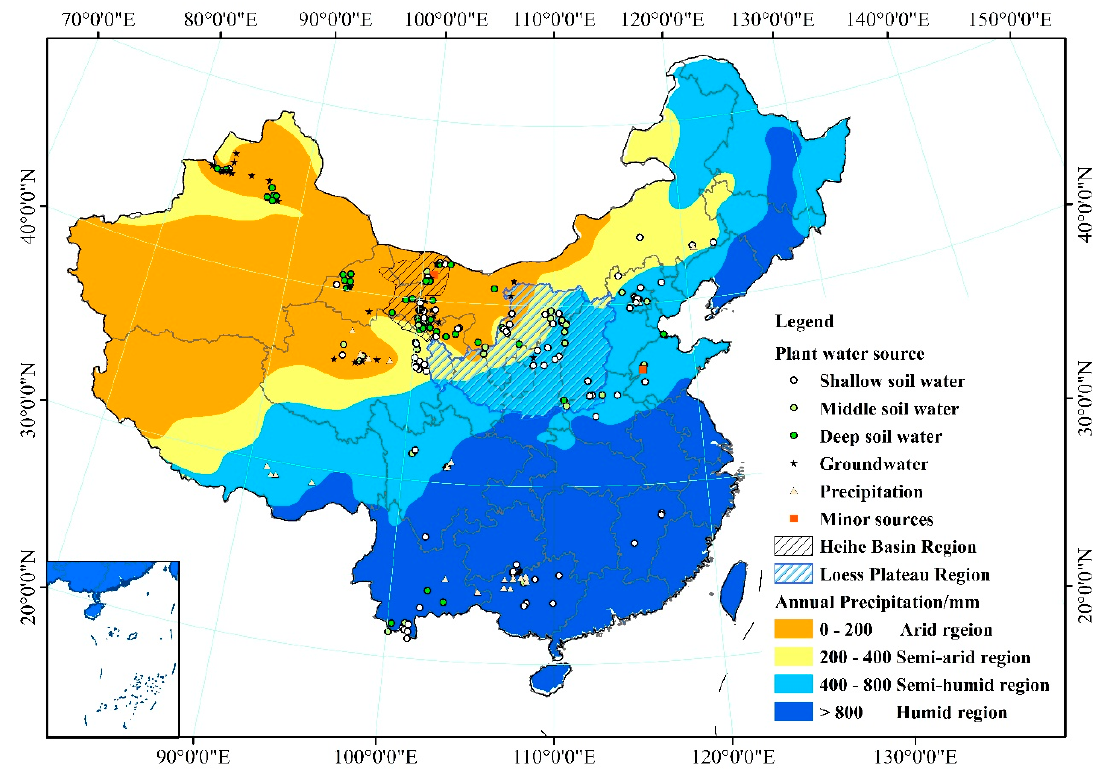
Figure 4. Plants’ main water sources in the wet season.